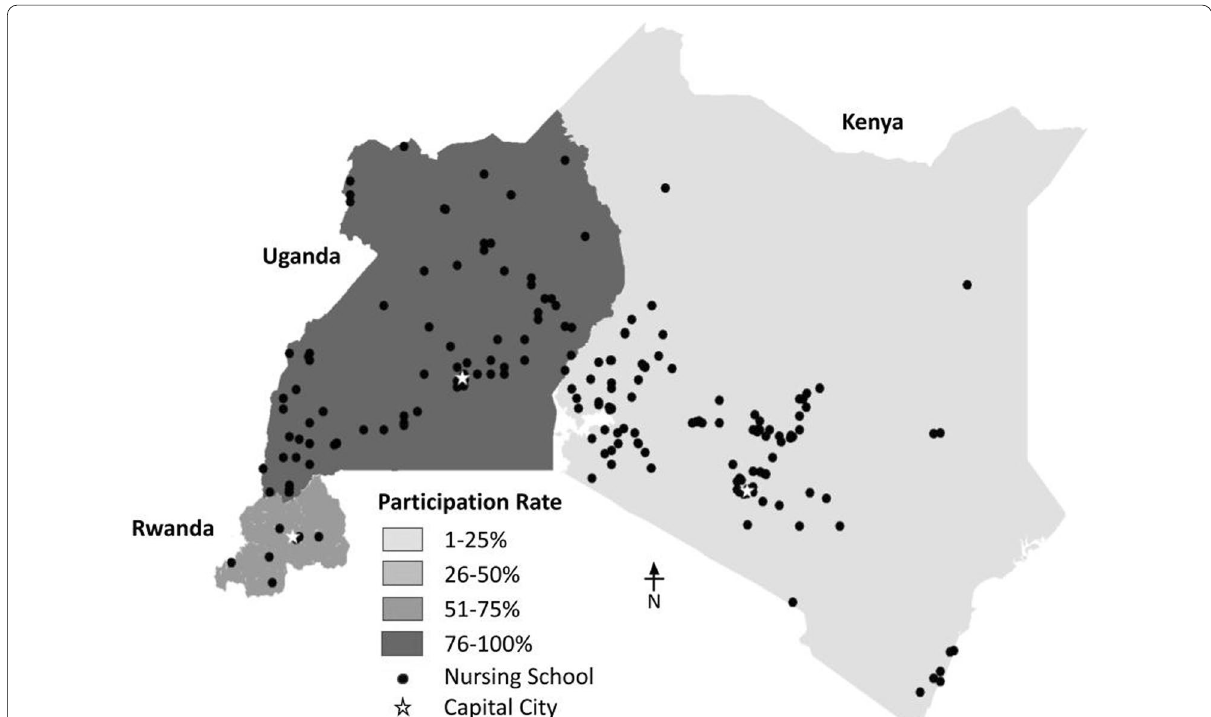
Fig. 1 Geographic distribution and survey participation among accredited nursing institutions in Kenya, Rwanda, and Uganda (N